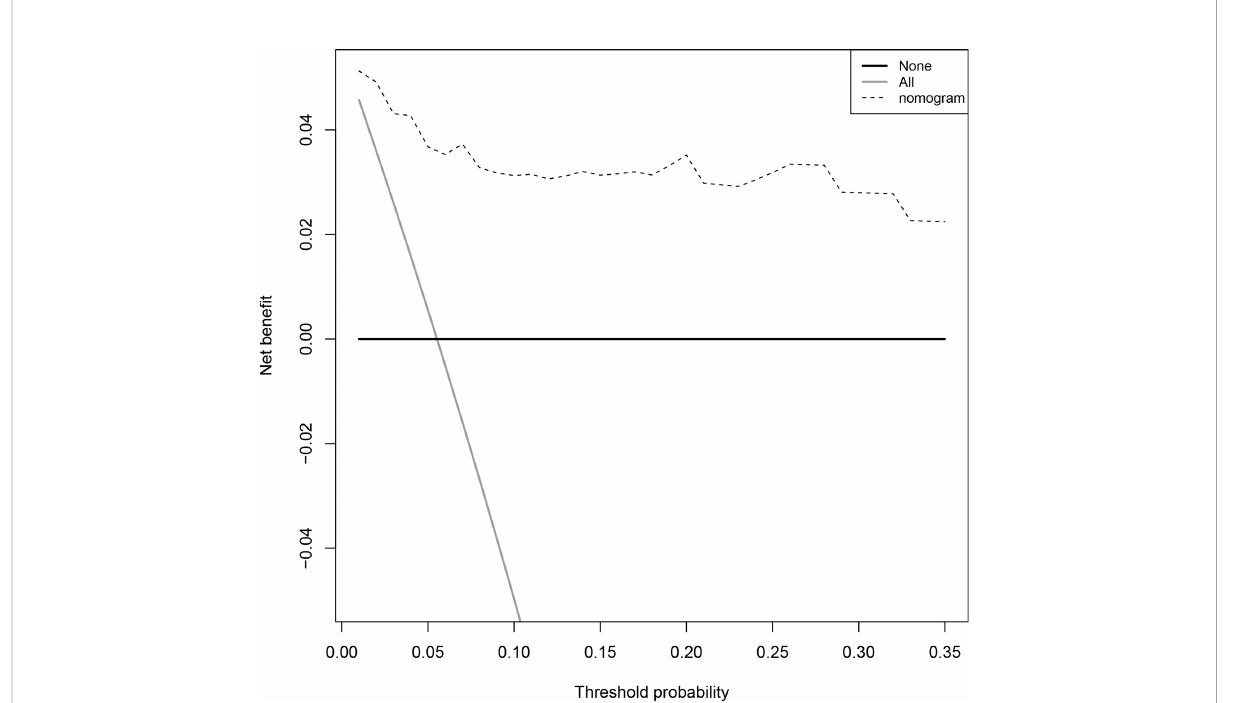
FIGURE 4 Decision curves for predicting the net bene fi t of the prognostic nomogram. A perfect prediction model (grey line), screen none (horizontal solid black line), and screen based on the nomogram (black dotted